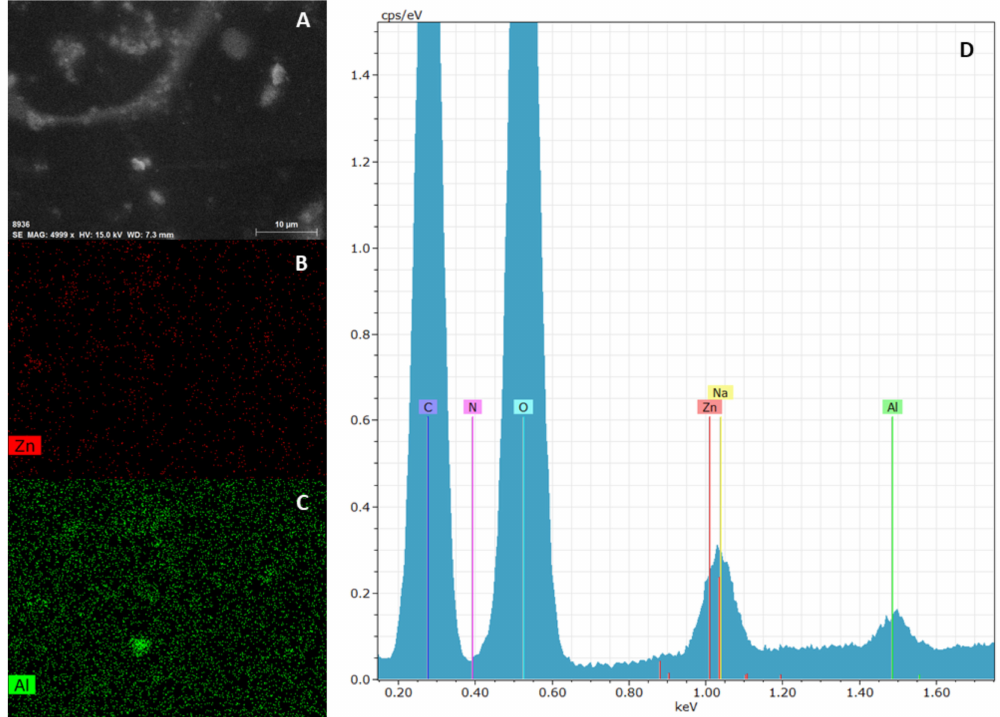
Figure 6. SEM analysis of ZnAl-KET loaded patch: micrograph ( A ), zinc mapping ( B ), aluminum mapping ( C ) and edx spectrum ( D ). Magnification 4999